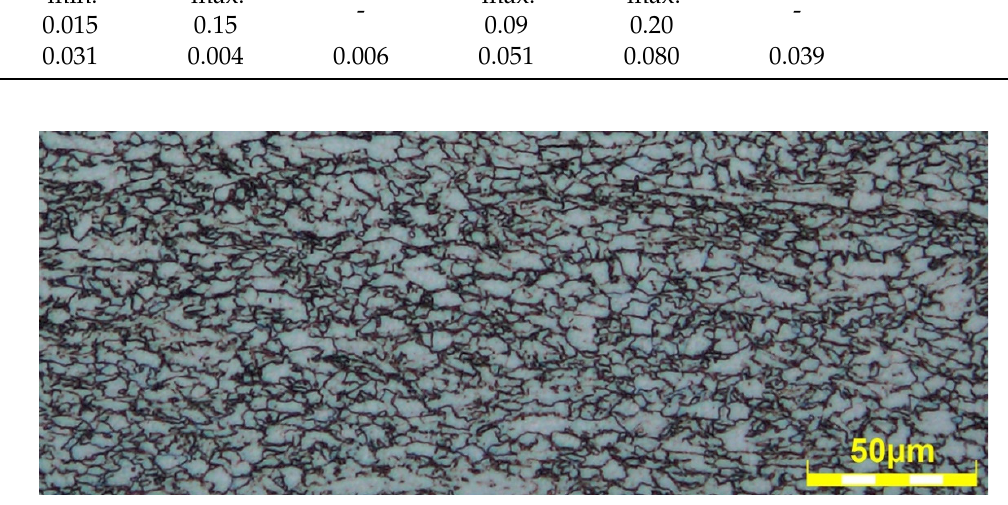
Figure 1. Metallographic structure of the base material—steel S460MC.